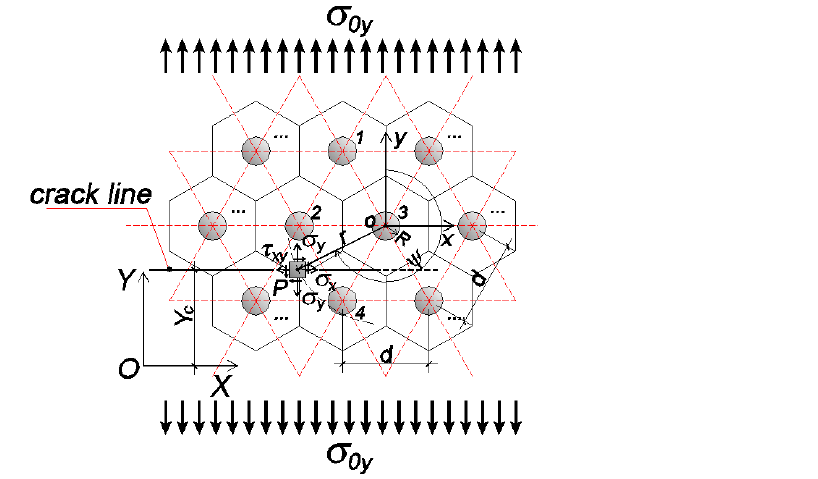
Figure 3: Equally-spaced circular inclusions in an infinite domain arranged in a hexagonal cell pattern having characteristic size d ,  . under remote uniform tensile stress 0 y